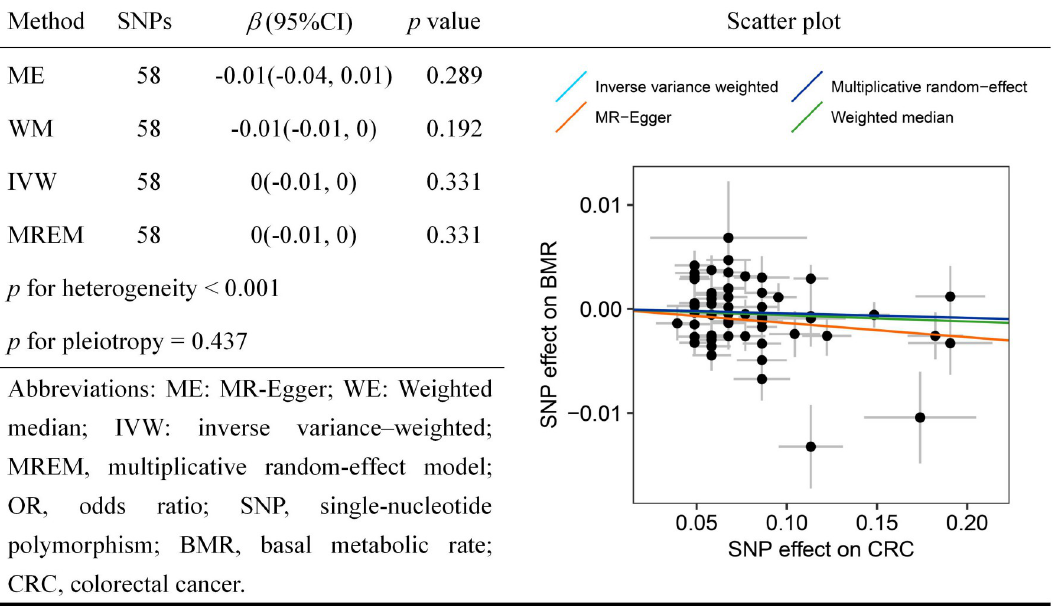
Fig 3. Mendelian randomization results for the relationship between colorectal cancer and basal metabolic